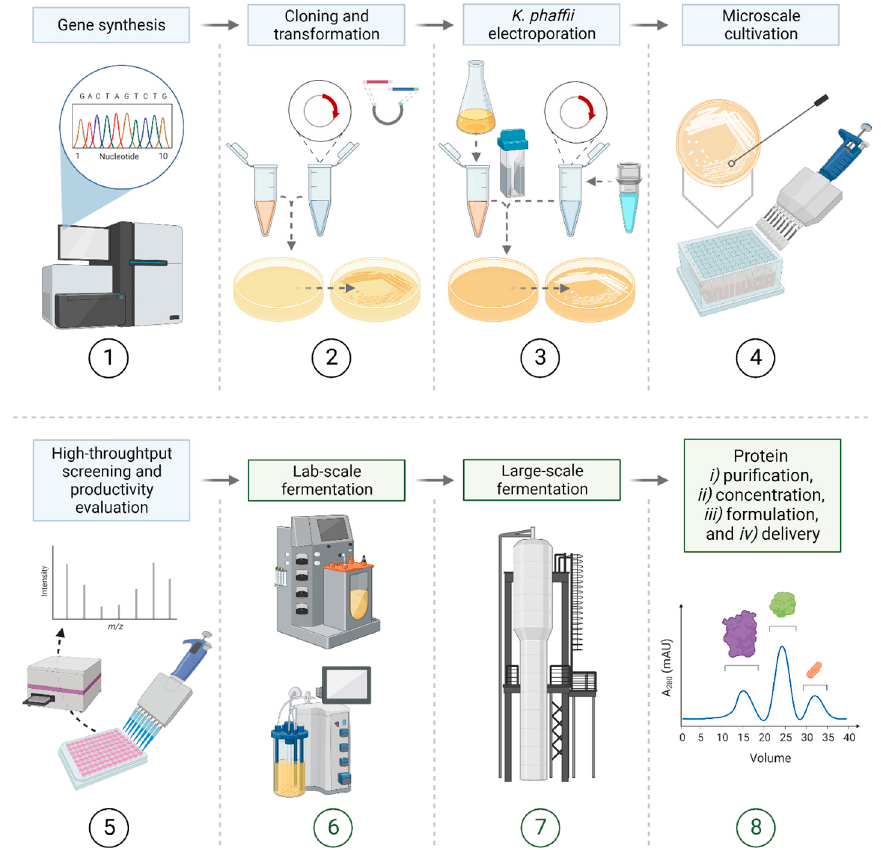
Figure 2. General workflow for the production of heterologous proteins and their industrial manu- facture with K. phaffii . The main steps are (1) gene synthesis; (2) cloning and transformation using E. coli ; (3) K. phaffii electroporation after the verification of the generated construct in the plasmid; (4) microscale cultivation of the colonies in 96-deep-well plates picked from the selective (e.g., anti- biotic, or heterotrophic compensation) agar plates; (5) high-throughput screening and evaluation of the productivity (e.g., colorimetric assay, and LabChip ® GXII Touch™ protein characterization system); (6) laboratory-scale fermentation (e.g., 3 L, 5 L, and 10 L); (7) large-scale fermentation; (8) final steps: protein ( i ) purification, ( ii ) concentration, ( iii ) formulation, and ( iv ) delivery. The light blue or green colour of the rectangular-shape text field indicates upstream (light blue) or downstream (green) part.